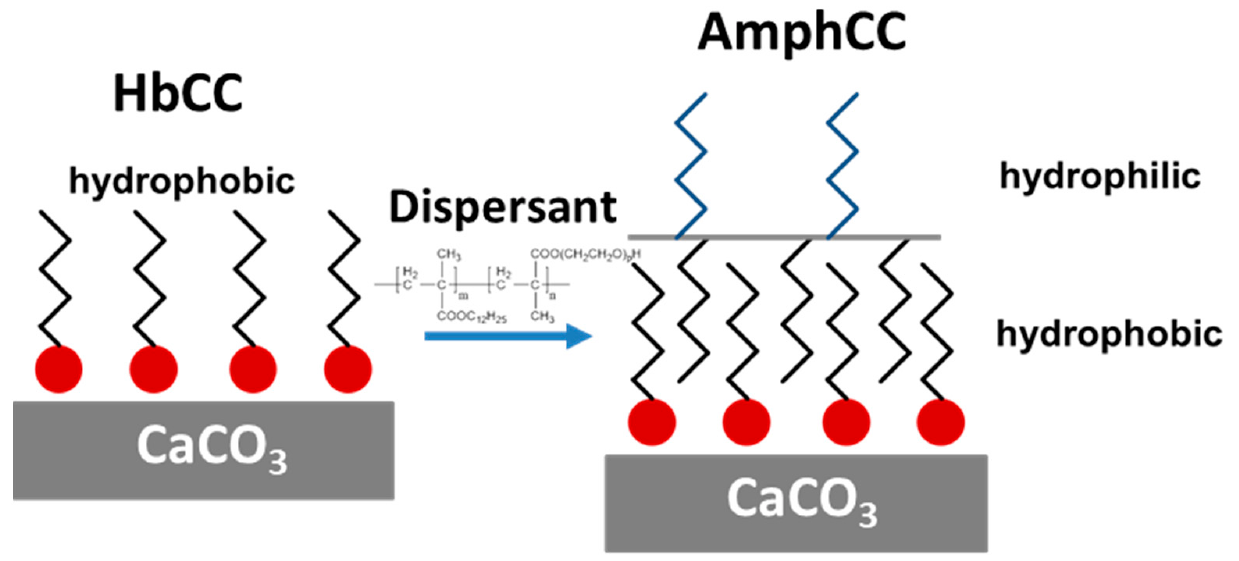
Figure 2. Mechanism of the dispersion process of AmphCC.